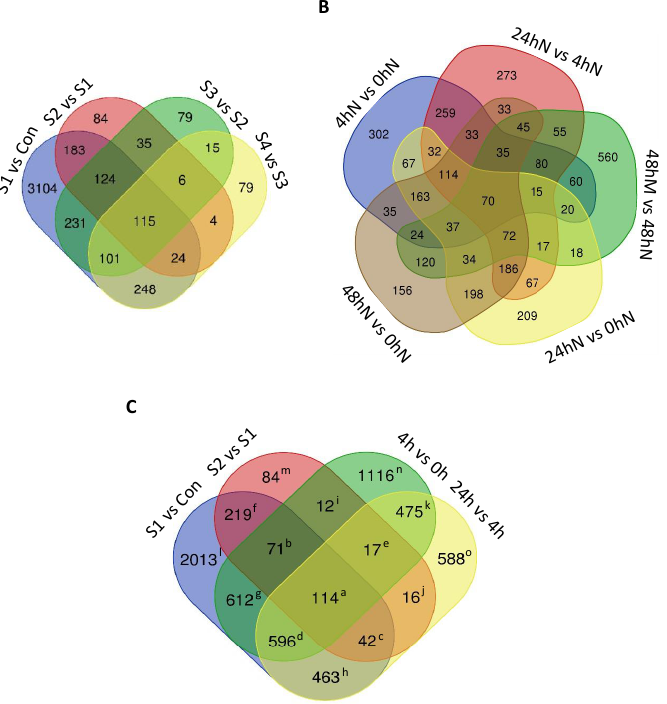
Figure 4. Venn diagrams showing the number of differentially expressed genes (DEGs) during plantlet formation. The number of DEGs overlapped from a comparison of ( A ) different plantlet developmental stages from K. daigremontiana or ( B ) samples harvested at specific time points upon K. pinnata leaf detachment. ( C ) The number of exclusive and overlapping differentially expressed genes between selected plantlet stages from ( A ) and time points from ( B ). Superscript alphabets correspond to the list of genes in Table S1 Con: Control; S1: Stage 1; S2: Stage 2; S3: Stage 3; S4: Stage 4; N: Leaf notches; M: Leaf mid-section.